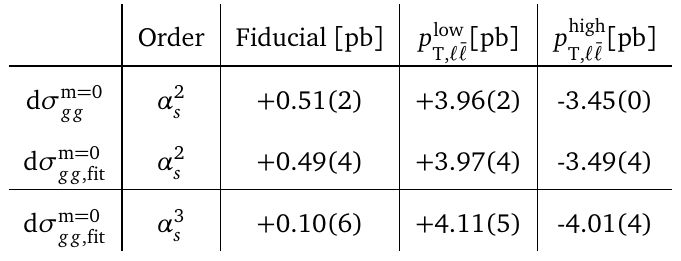
Table 1: Predicted and fitted values of the coefficient of the zero-mass computation ) in the g g -channel. The results are for the central scale, and include an up to O ( α 3 s uncertainty due to the fitting procedure and the statistical